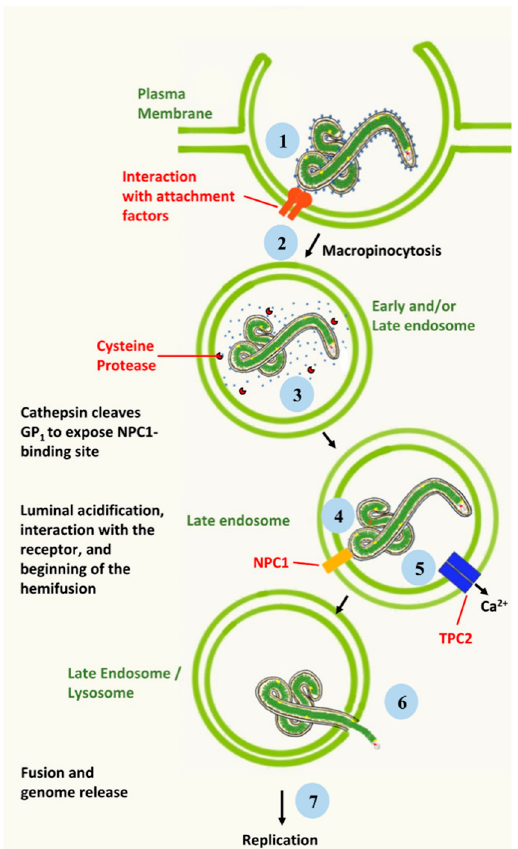
Figure 1. Schematic representation of EBOV entry. Following interaction with attachment factors (1), the virion is internalized by the macropinocytosis (2). Inside the membrane-bound vesicle, GP is cleaved by cysteine proteases to activate its fusogenic potential (3). Cleaved GP is then able to interact with the specific NPC1 viral receptor (4). Such event, in addition to the activity of the TPC2 calcium channel (5), helps triggering the fusion between the viral envelope and the endosomal/lysosomal membrane (6), leading to viral genome release followed by transcription and replication (7).